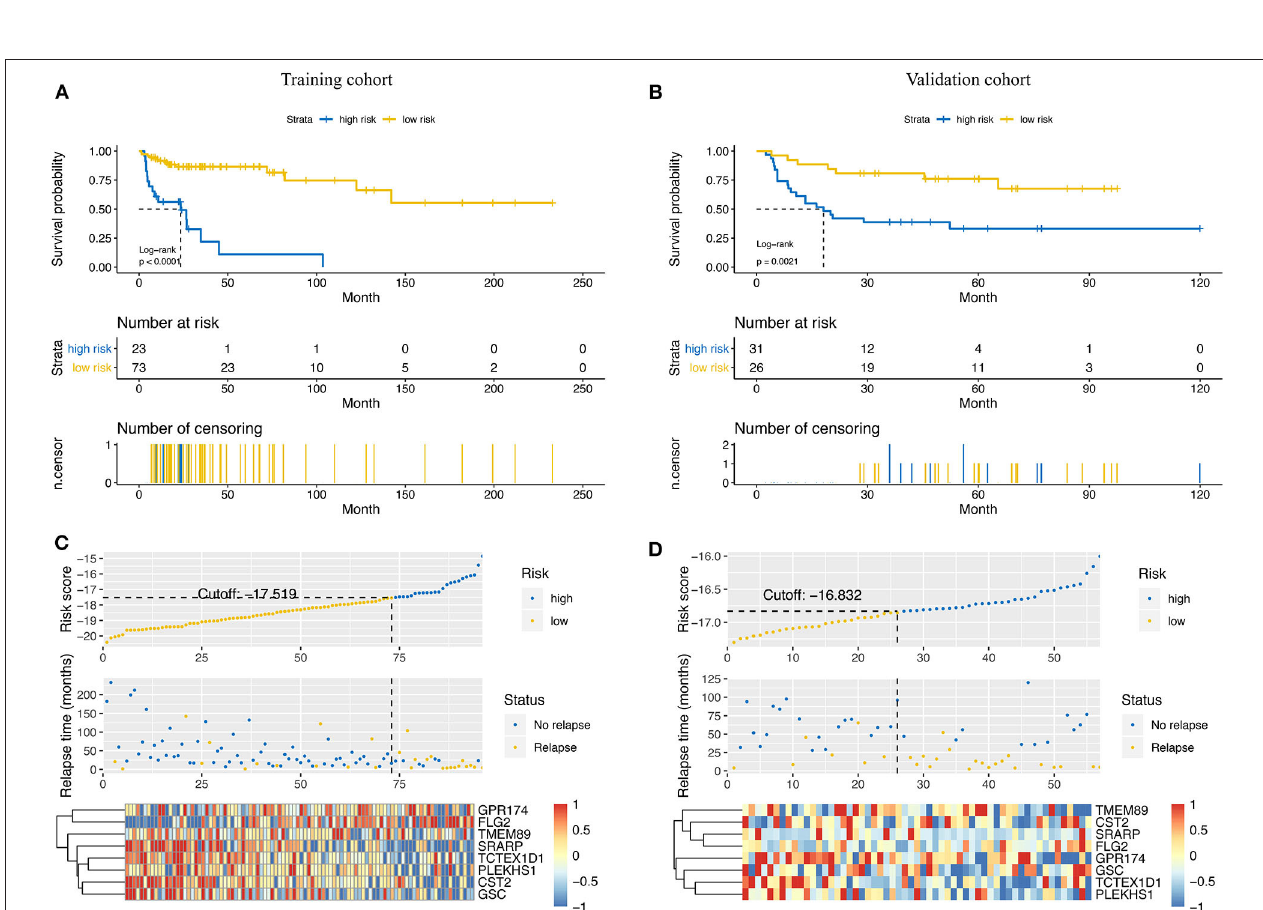
FIGURE 3 | Prediction power of the risk score model in the training cohort and the validation cohort. Kaplan–Meier curves of relapse-free survival in the training cohort (A) and the validation cohort (B) stratified by risk scores. Rank of risk scores and relapse status for each patient in the training cohort (C) and the validation cohort (D) . Heatmaps show the eight prognostic genes in the training cohort (C) and the validation cohort (D) between the high- and low-risk groups.